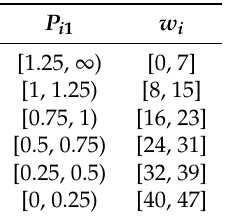
Table 1. Mapping relationship between P i 1 and w i